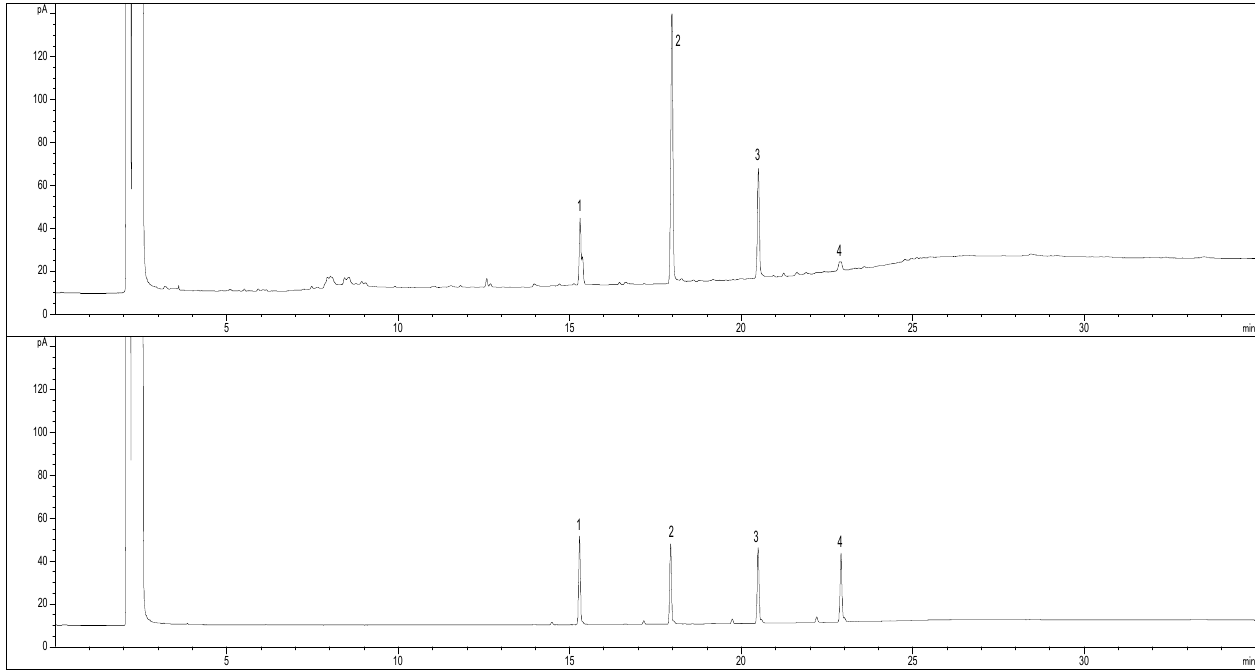
Figure 2. Gas chromatograms of PC that was obtained from E. pela wax ( upper ) and standard compounds ( bottom ). 1. tetracosanol; 2. hexacosanol; 3. octacosanol; 4. tricaontanol. The column was HP-5 (30 m × 0.25 mm × 0.25 µ m) and the other parameter settings were designated as follows: injector 320 °C, detector 340 °C, column oven starting at 200 °C (1 min) and increasing to 320 °C (10 min) at a rate of 5 °C/min, holding for 10 min. carrying gas, nitrogen; fuel gas, hydrogen; flow rate: 1.0 mL/min, hydrogen flow rate, 30 mL/min; air flow rate, 300 mL/min; and sample volume: 2 μ L without splitting. The PC sample was dissolved in chloroform and injected onto the top of the col- umn after filtration through a 0.45 μ m PVDF film.